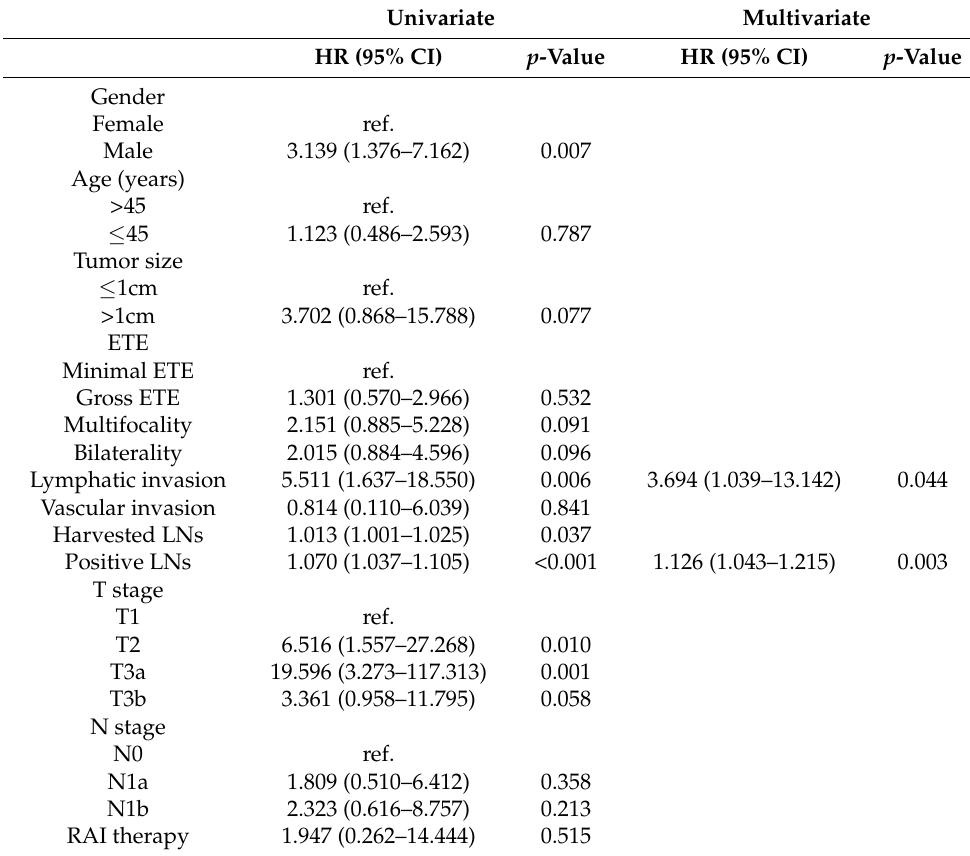
Table 4. Univariate and multivariate analyses of risk factors for recurrence after propensity score